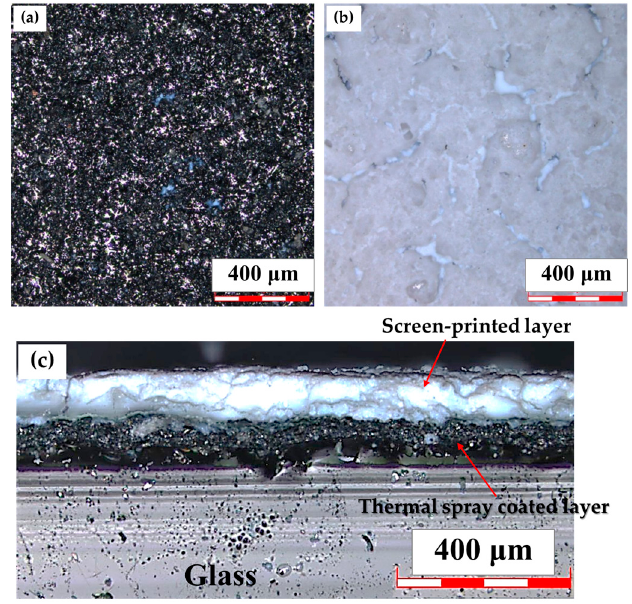
Figure 1. Optical images obtained by confocal microscope showing the ( a ) top view of thermal spray coated film; ( b ) top view of screen-printed film; and ( c ) cross section of the screen-printed layer on the thermal spray coated layer.